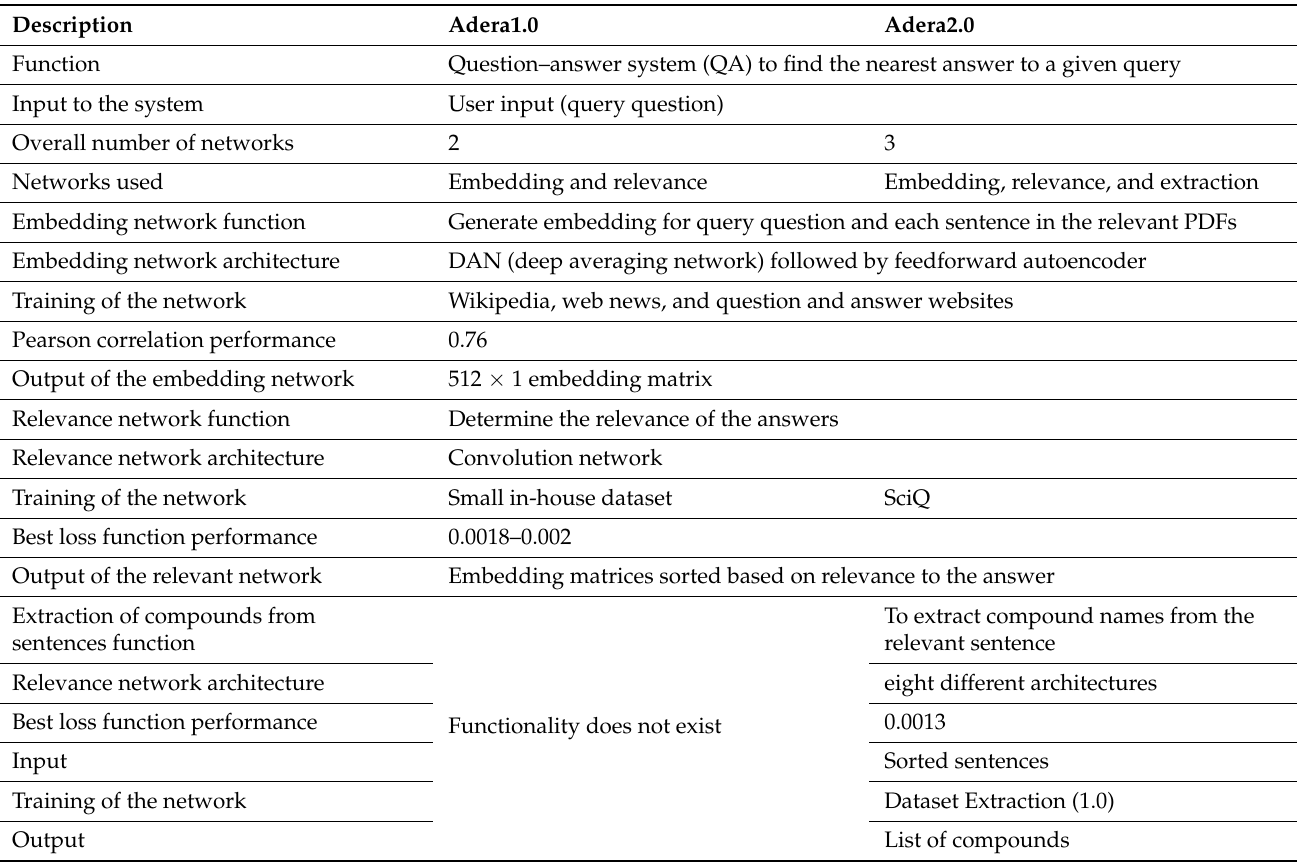
Table 3. Comparison between Adera1.0 and